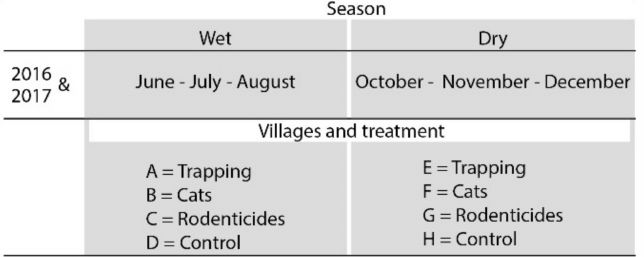
Figure 2. Overview of the study design of eight selected villages in